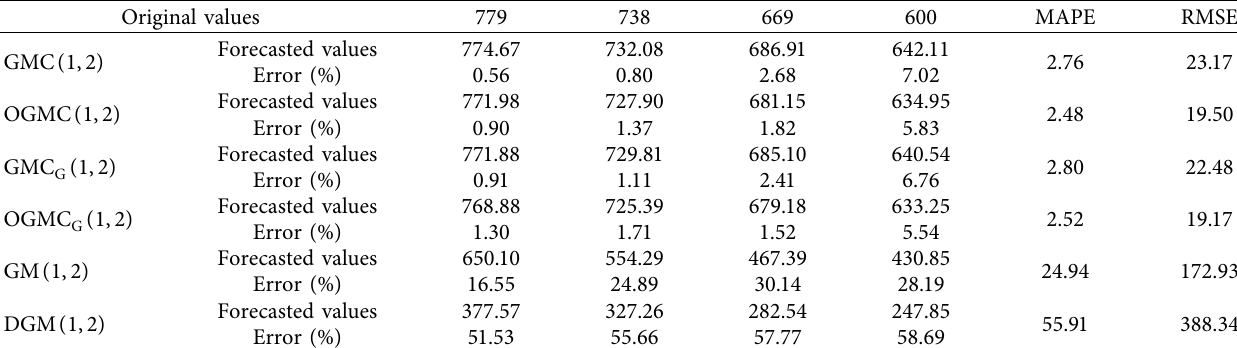
Table 3: The forecasted results and the values of three indices measuring accuracy by six competing models in case one. Original values